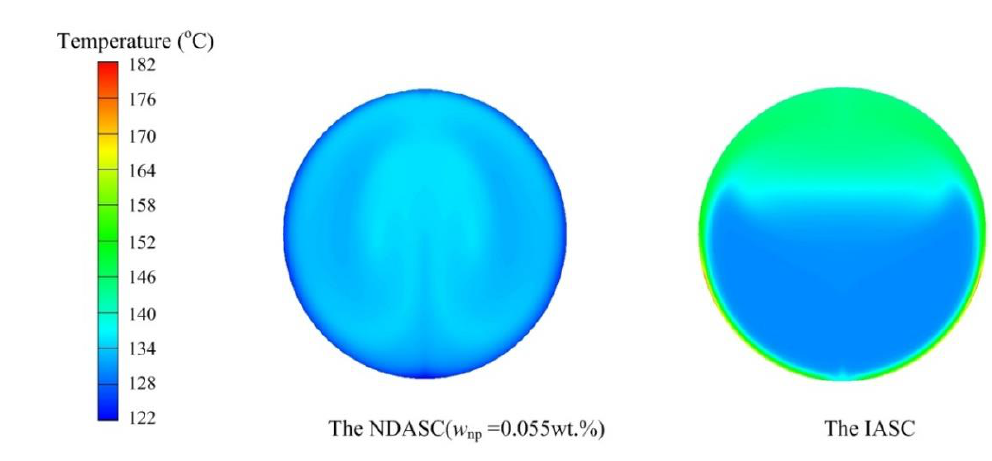
Figure 8. Fluid’s temperature distribution at z = 1.7 m in the NDASC and IASC ( t f,i = 130